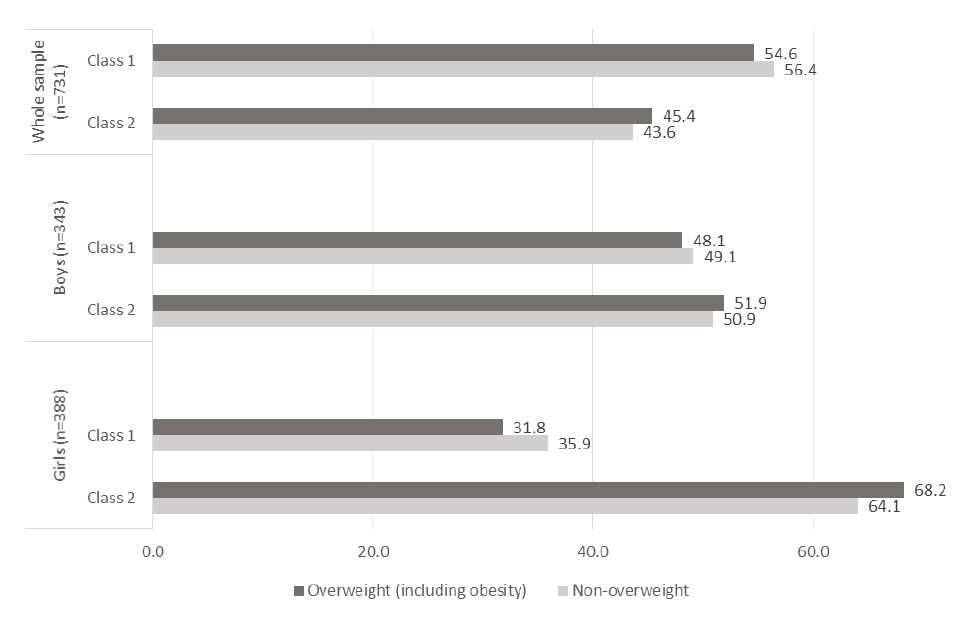
Figure 2. Weight status according to classes of behaviors in Brazilian adolescents. Florianópolis, Santa Catarina, Brazil, 2017. Note: chi-square test indicated no statistical significant differences.